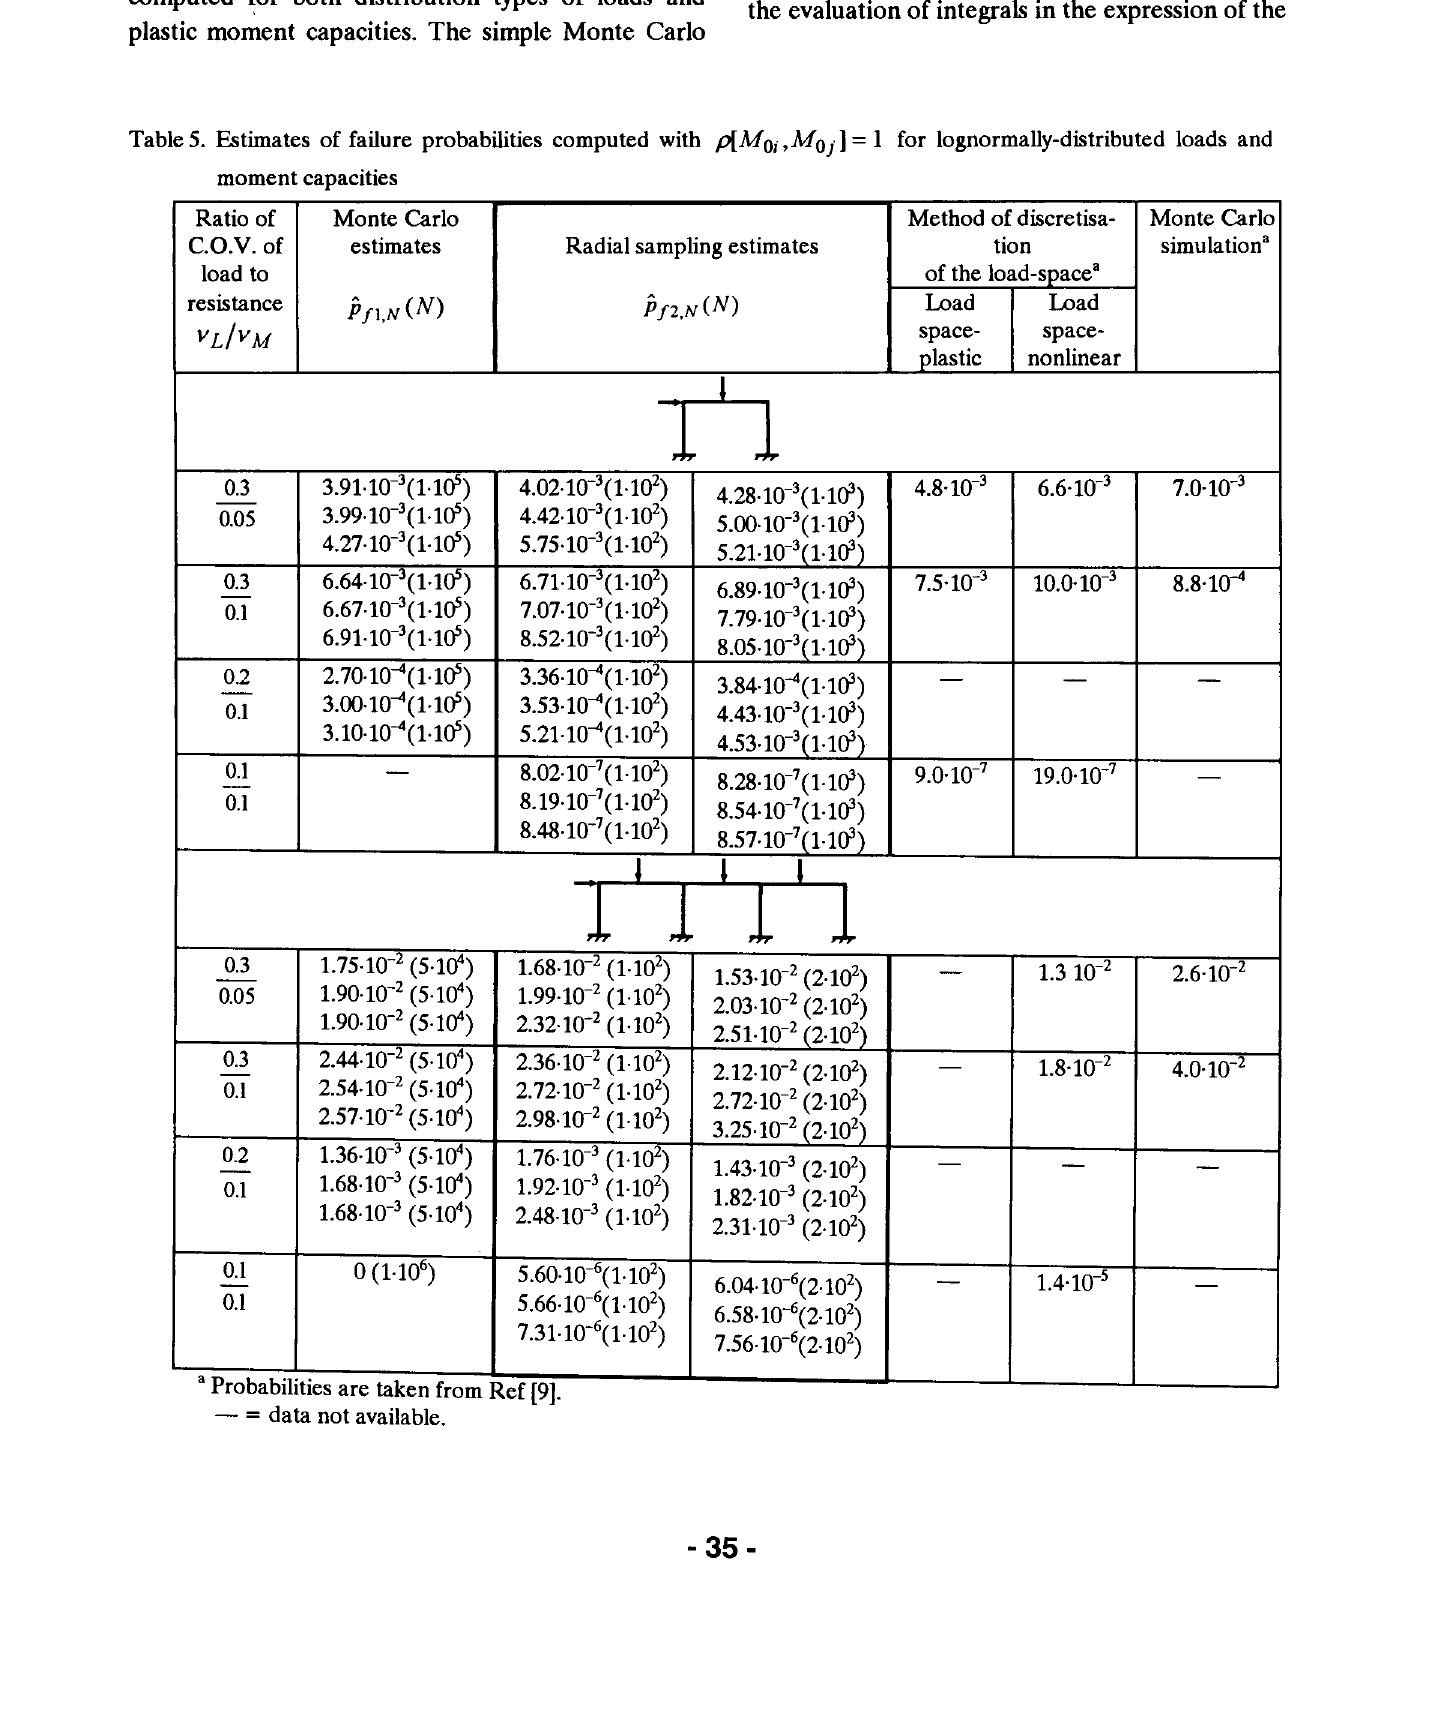
Table 5. Estimates of failure probabilities computed with p[ M o;, M 01 ] = 1 for lognormally-distributed loads and moment capacities Ratio of Monte